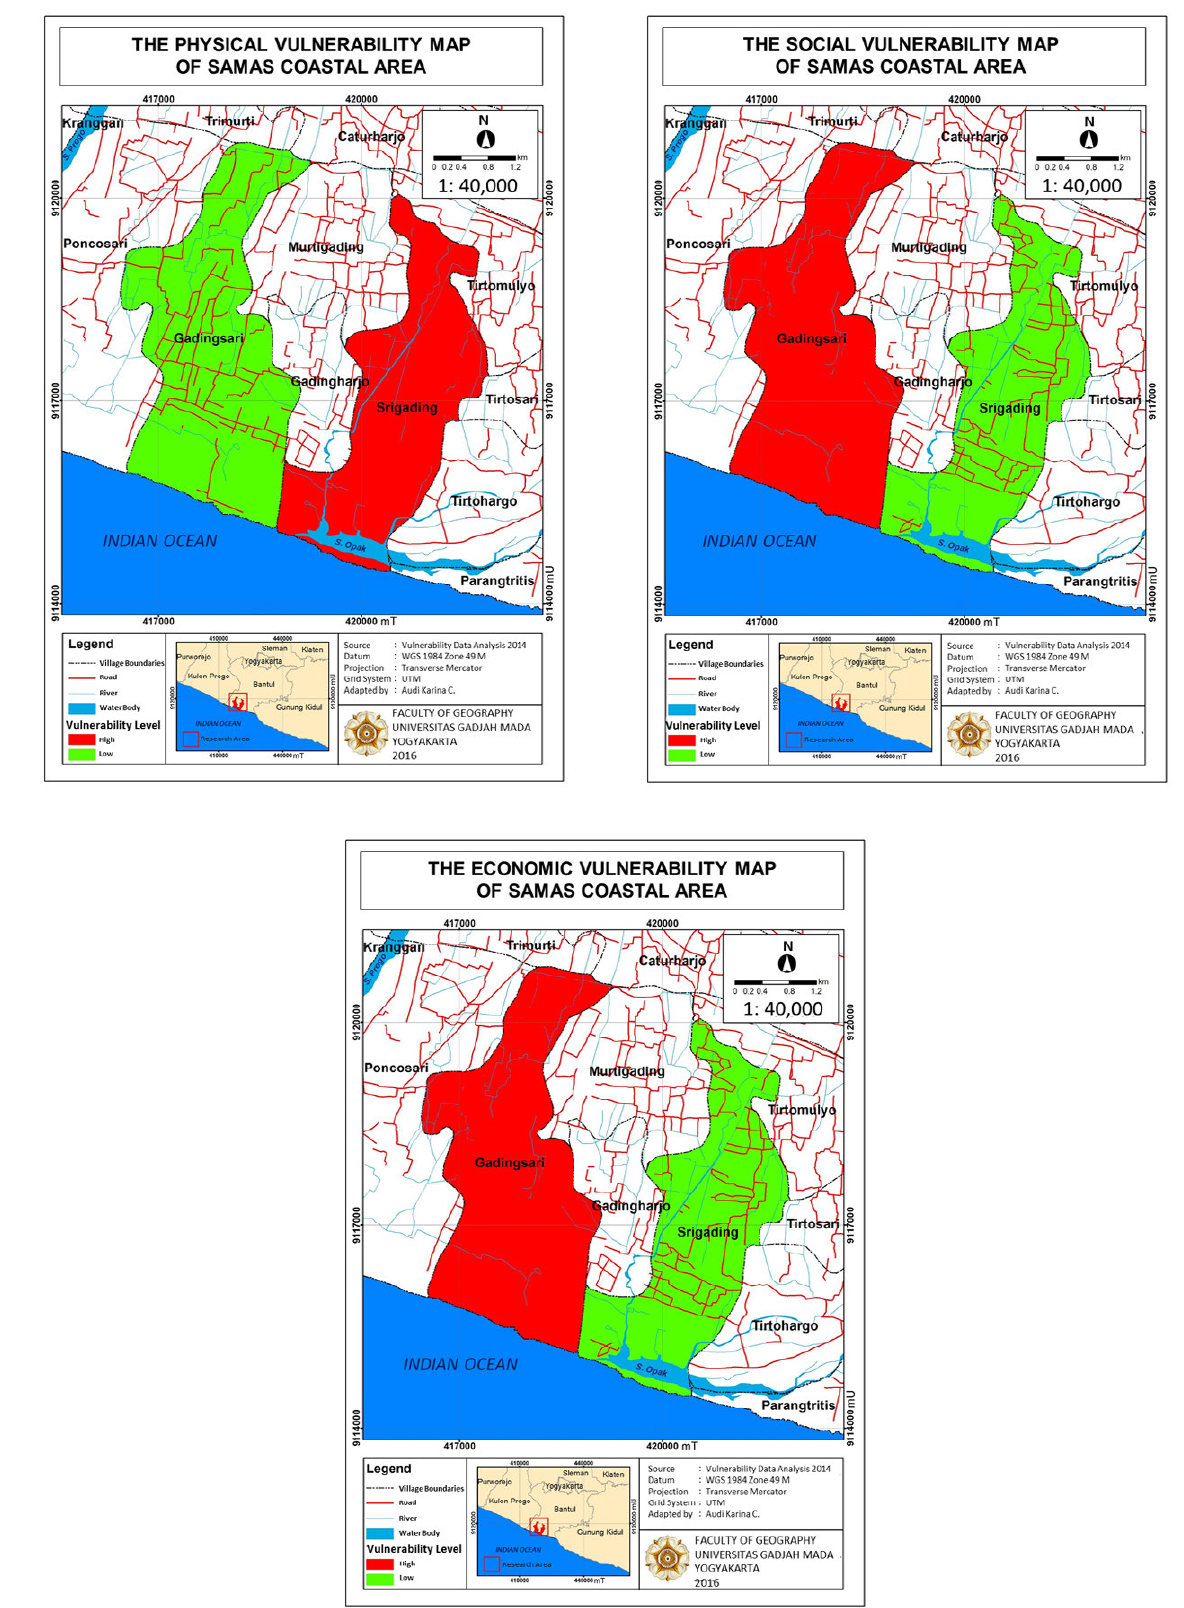
Fig. 3. Maps of physical, social, and economic vulnerability by Choirunnisa